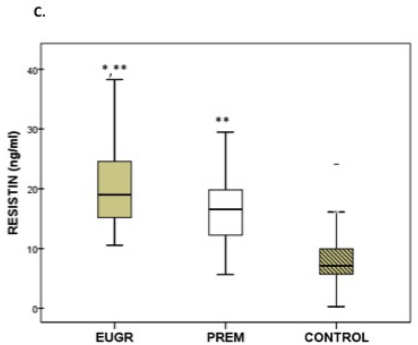
Figure 1. Concentration of adiponectin ( A ), leptin ( B ) and resistin ( C ) in prepubertal children with a history of prematurity and extrauterine growth restriction (EUGR) ( n = 38), premature without EUGR (PREM) ( n = 50) and control children ( n = 123). Values are expressed as medians and interquartile ranges. * Median value was significantly different from that of the PREM group with p < 0.05. ** Median value was significantly different from that of the CONTROL group with p < 0.05 (Mann–Whitney U test). p , probability adjusted for gestational age, birth weight and length. Adiponectin: EUGR vs. PREM p < 0.001, EUGR vs. CONTROL p < 0.001; PREM vs. CONTROL p = 0.004. Leptin: EUGR vs. PREM p = 0.048, EUGR vs. CONTROL p = 0.214, PREM vs. CONTROL p = 0.029. Resistin: EUGR vs. PREM p = 0.007, EUGR vs. CONTROL p < 0.001, PREM vs. CONTROL p < 0.001.